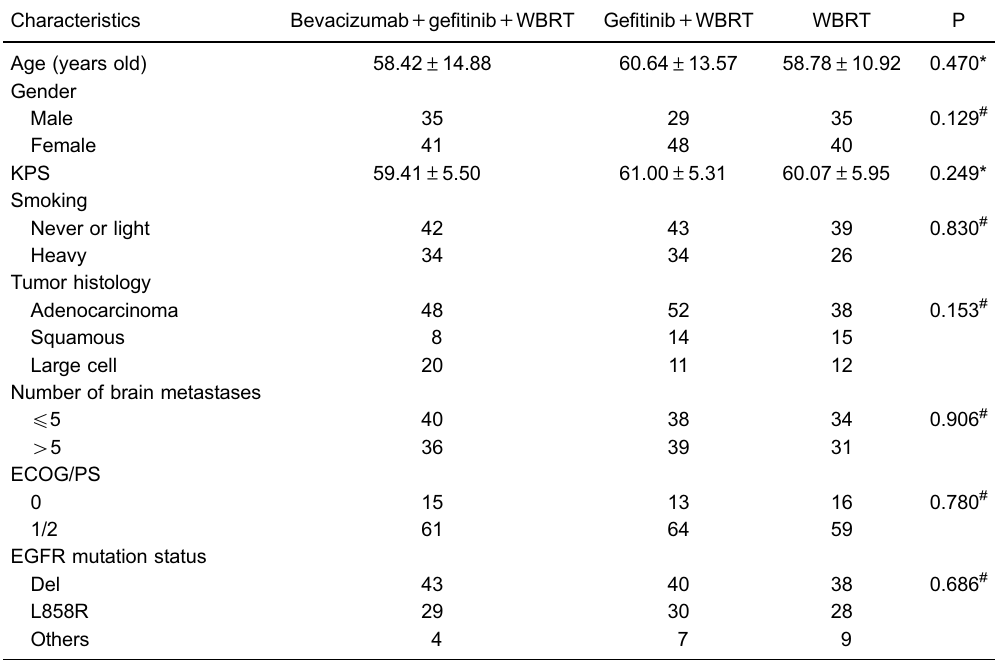
Table 1. Clinical characteristic of non-small-cell lung cancer patients with brain metastases treated with bevacizumab + ge fi tinib + WBRT, ge fi tinib + WBRT and WBRT.